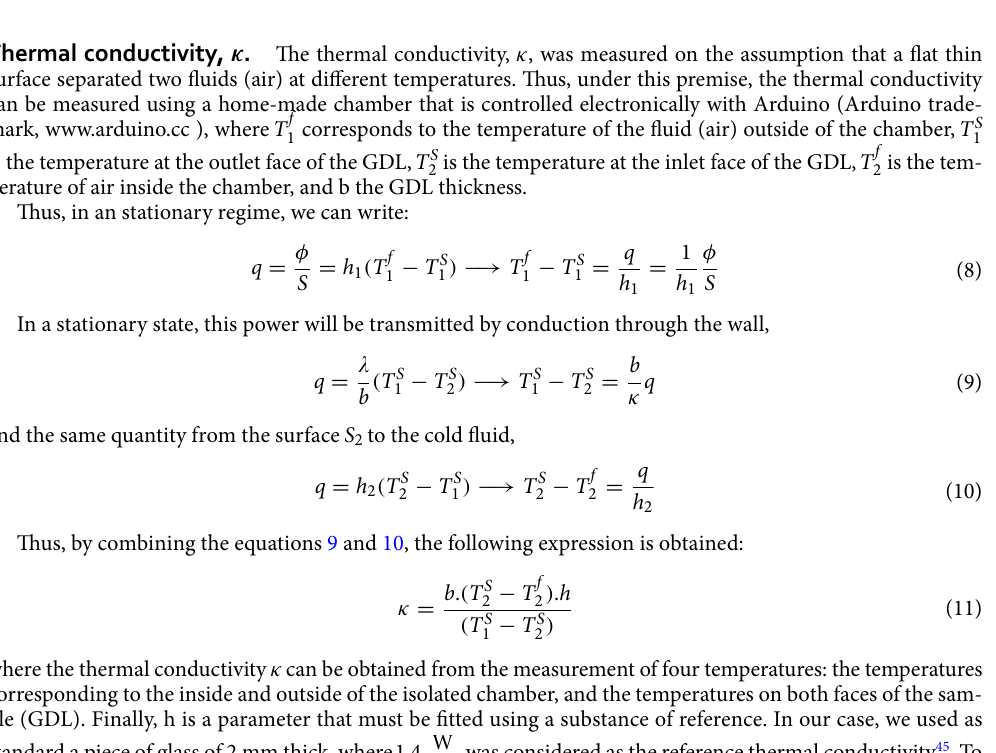
Figure 8. Thermal conductivity of a GDL with 40% cotton fiber content and Sigracet 38BC, as a function of temperature. Error bars were determined from three different